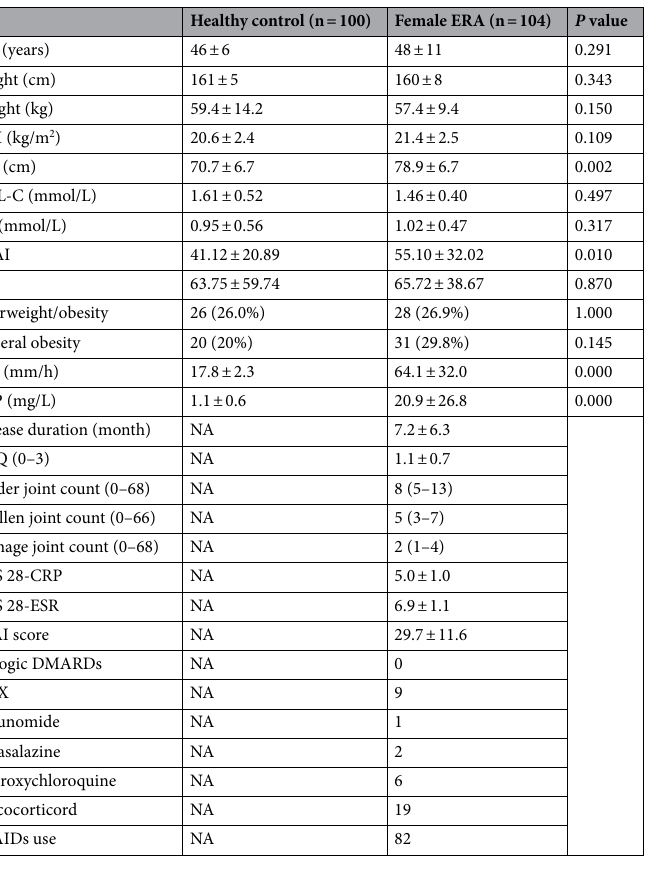
Table 1. Baseline characteristics of participants. BMI: body mass index; WC: waist circumference; FBG: fasting blood glucose; LDL: low density lipoprotein; HDL: high density lipoprotein; TC: total cholesterol; TG: triglyceride; CVAI: Chinses visceral adiposity index; VAI: visceral adiposity index; ESR: erythrocyte sedimentation rate; CRP: C- response protein; HAQ: Health Assessment Questionnaire; DAS28: Disease Activity Score in 28 joints; SDAI: Simple Disease Activity Index Score; DMARD, disease modifying anti- rheumatic drugs; MTX, Methotrexate; NSAIDs, non-steroidal anti-inflammatory drugs. P value: healthy control &